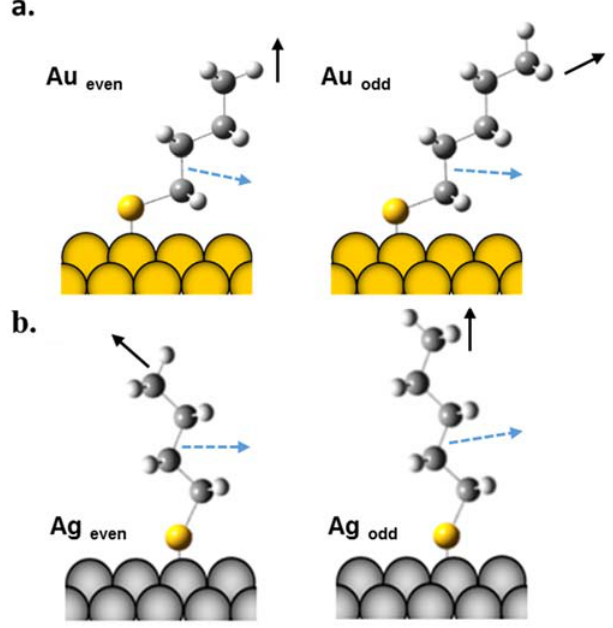
Figure 3. ( a ) Schematic illustration of the structural effect of the SAM tilt angle, surface dipole and orientation of the terminal moiety on Au; ( b ) Schematic illustration of the structural effect of the SAM tilt angle, surface dipole (dotted arrows) and orientation of the terminal moiety (solid arrow) on